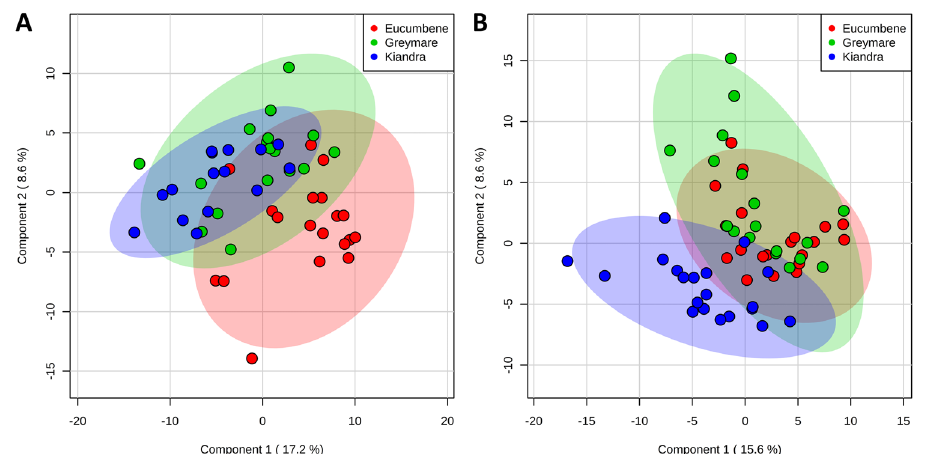
Figure 6. Partial Least Squares discriminant analysis (PLS-DA) scores plots of components one and two, comparing skin samples ( A ) and liver samples ( B ) as they cluster by source